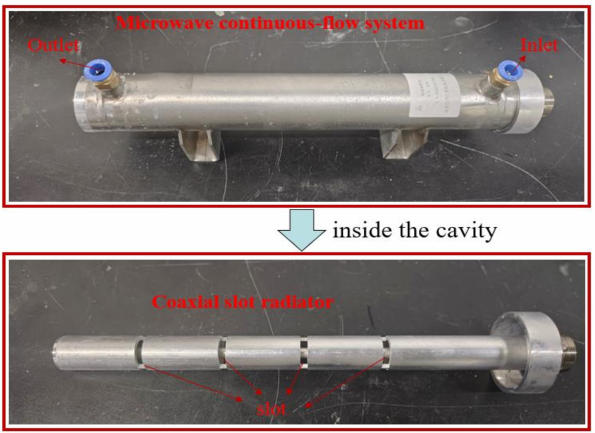
Figure 2. Microwave continuous-flow milk sterilisation system.